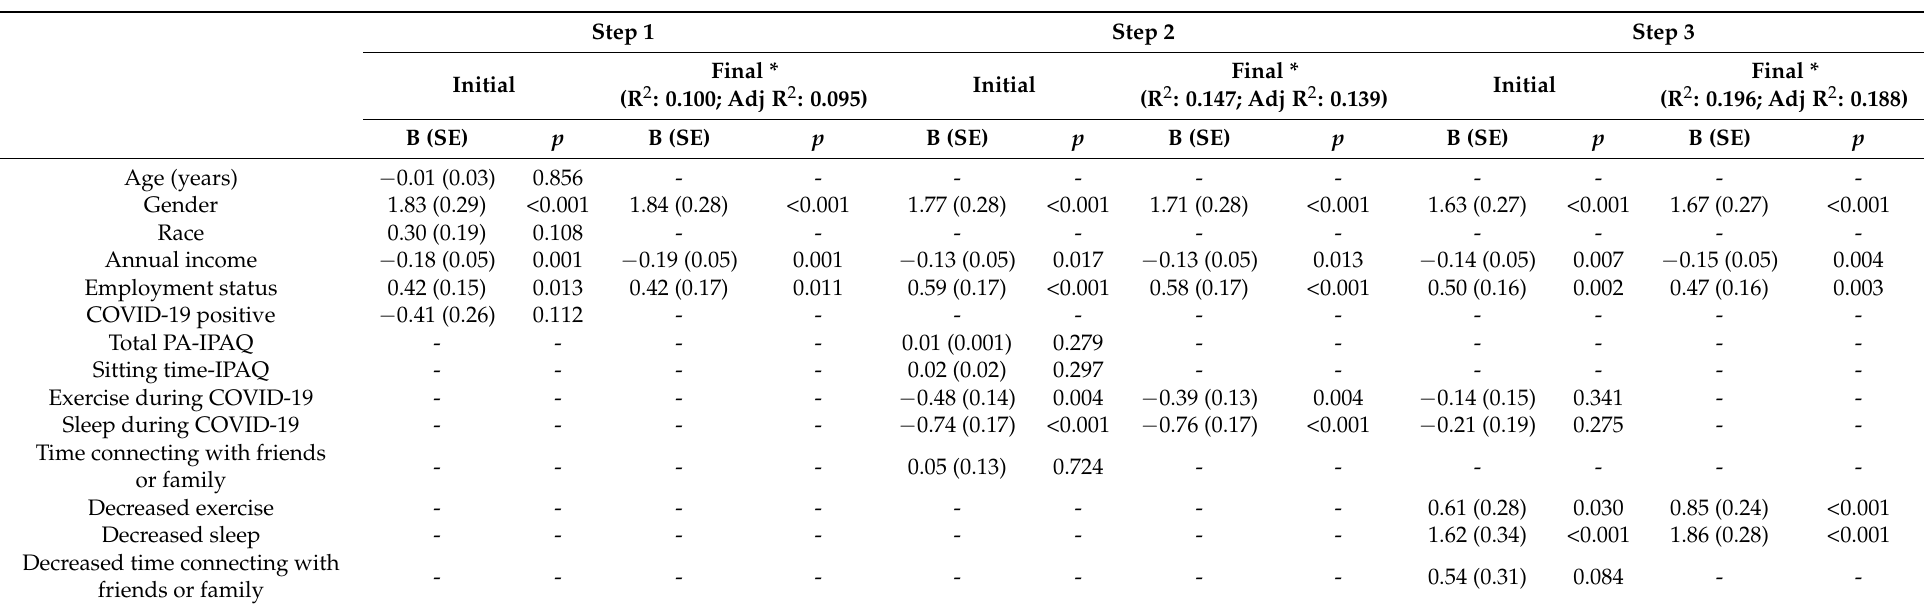
Table 4. Hierarchical regression analysis for factors associated with the PSS score ( n = 528).